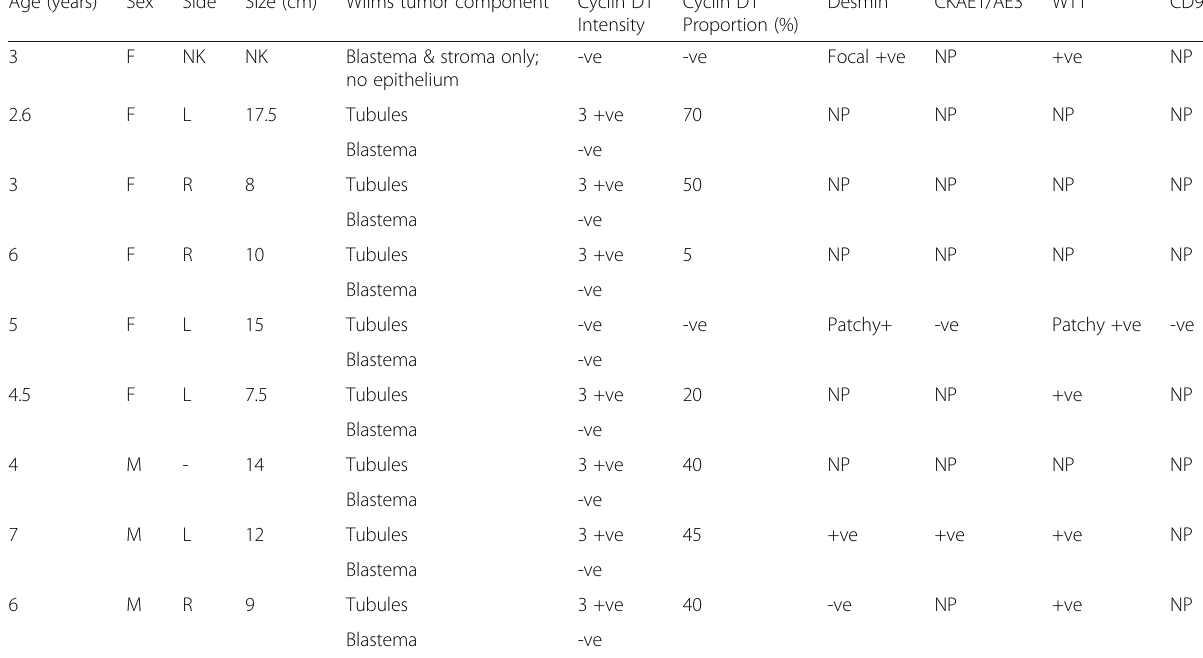
Table 2 Clinical details and results of immunohistochemical staining with Cyclin D1 and other IHC markers in Wilms tumor ( n = 9) Age (years)